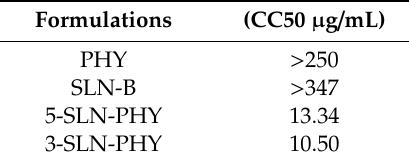
Table 4. CC 50 values for di ff erent